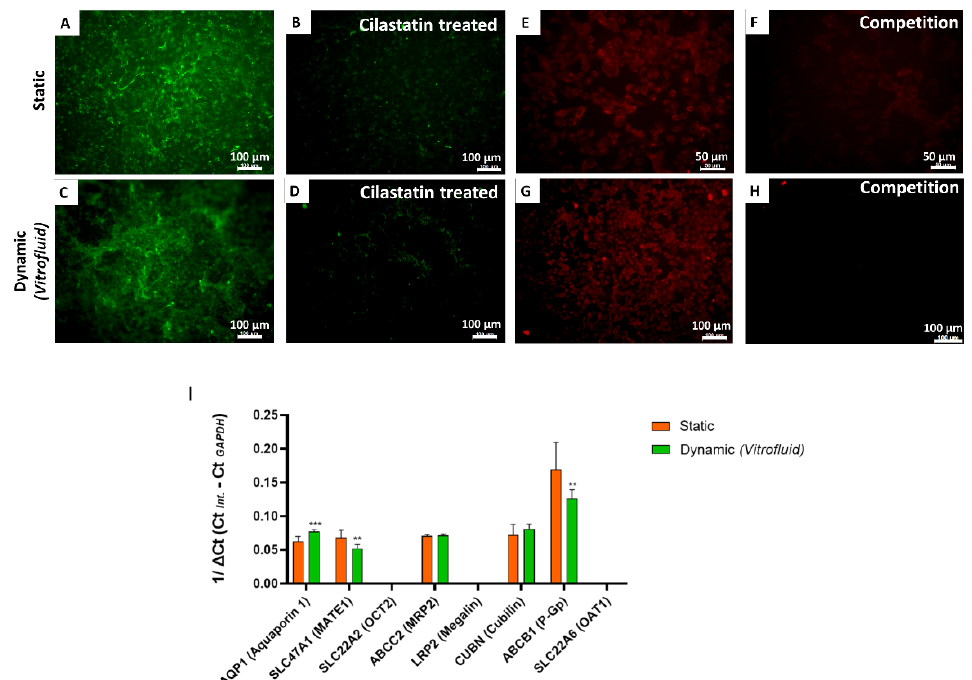
Figure 6. Albumin and transferrin uptake in RPTEC cultures under static and dynamic conditions on day 7: Cellular uptake of albumin-FITC (green) in the presence ( B , D )/absence ( A , C ) of cilastatin (inhibitor of megalin/cubilin-mediated uptake). Cellular uptake of transferrin 546 (red) in the presence ( F , H ) and absence ( E , G ) of excess unlabeled transferrin (competition assay). Control cultures were pretreated overnight with cilastatin (200 µg/mL; B – D ) or for 15 min in a solution of unlabeled transferrin (1 mg/mL; F , G ). (I) Gene expression of renal transporters in RPTECs under static and dynamic culture conditions: Transporter expression was evaluated on day 7. Data are shown as 1/ΔCt. GAPDH was used as housekeeping gene (mean ± SD; n = 3 biological repeats in technical triplicates; Student’s t -test; ** p ≤ 0.01, *** p ≤ 0.001).